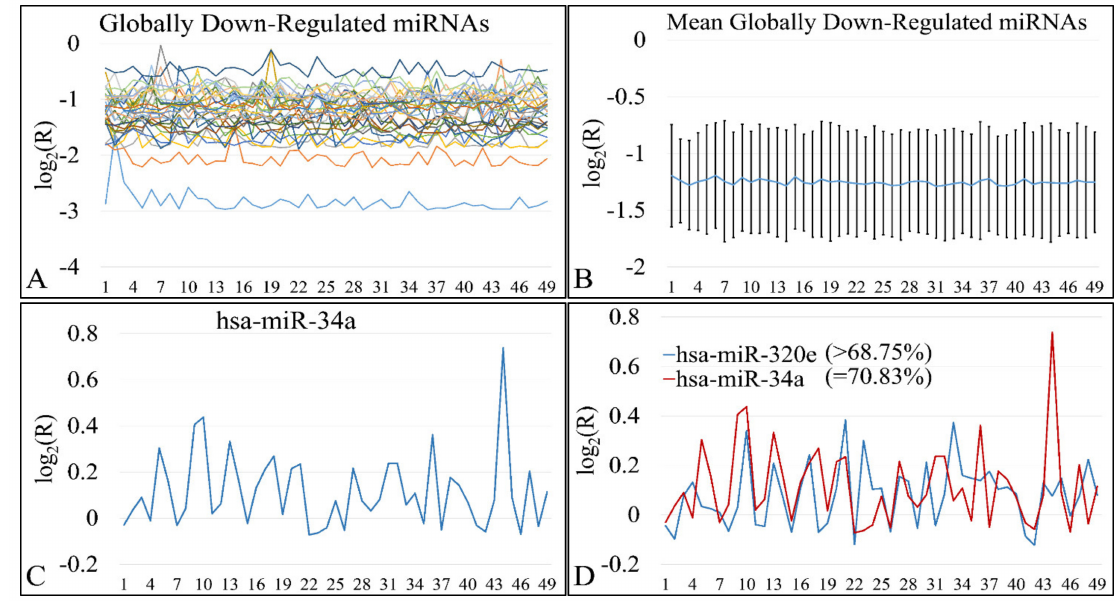
Figure 17. Globally down- and up-regulated miRNAs. 31 miRNAs were found to be globally down-regulated in all tumor samples ( A , B ). On the other hand, one miRNA (miR-34a) was found to be globally up-regulated in ~70% of all tumors ( C ), while miR-320e was the next miRNA with ~68% up-regulation in all tumors ( D